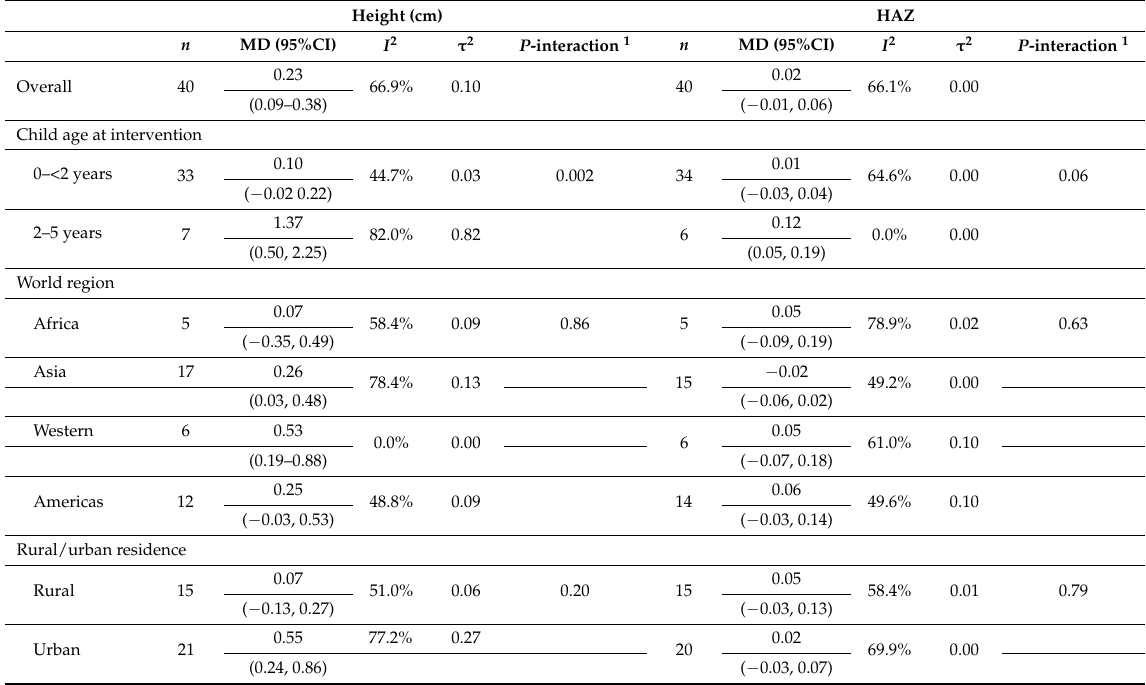
Figure 2. Effect of zinc supplementation among children aged < 5 y old on HAZ in randomized controlled trials. Table 3. Main and subgroup analyses of zinc supplementation during infancy/childhood on height and HAZ.